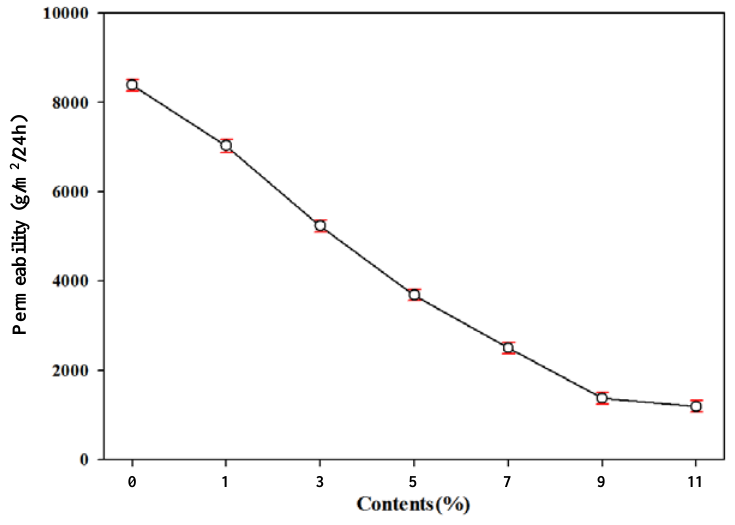
Figure 8. Water vapor permeability of polyester thermoplastic film with various contents of thermally expandable microcapsules.